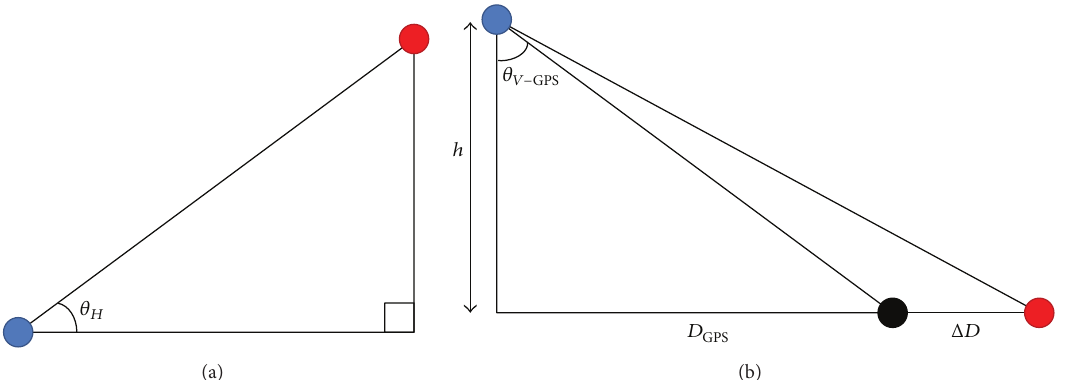
Figure4:(a)Planviewand(b)sideviewschematicfortheGPSpositionofaparticularpositionrecordedbythetheodolite(reddot)compared to the position collected with the onboard GPS (black dot) extracted from Figure 3. The blue dot is the shore-based station.